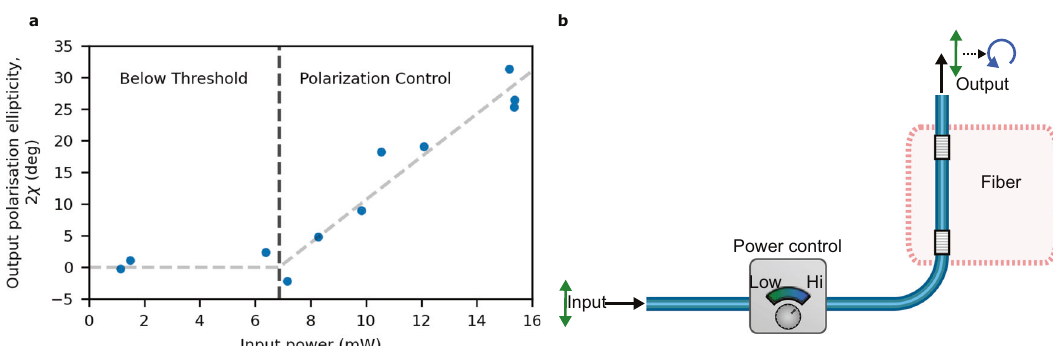
Fig. 4 Polarization control using the Kerr effect. a Experimental demonstration of the control of the output fi eld ’ s ellipticity, given by the Stokes parameter χ , for different input powers. The output light remains linearly polarized ( χ = 0) for powers below threshold after which it becomes increasingly circular with increasing input power. b Concept of a Kerr polarization controller. Linearly polarized light is input into a cavity such that the output polarization can be controlled by modifying the input intensity. The cavity must be slightly biased towards one circular polarization, forcing the output to have the